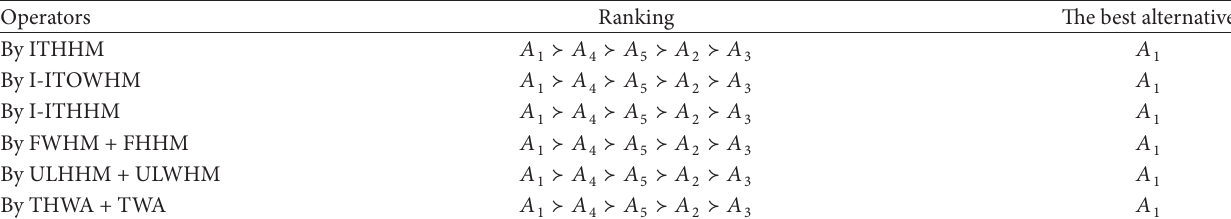
Table 4: Ranking